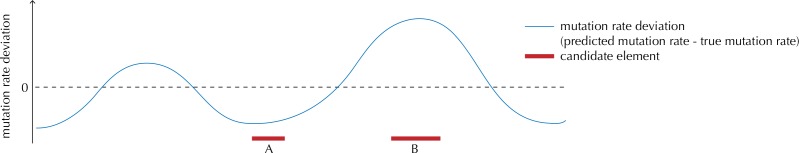
Illustration of the motivation behind the overdispersion-based rate adjustment.For candidate element A, we overestimate the mutation rate, and thus end up with a conservative p-value for this element when analysing it with ncdDetect. For candidate element B, on the other hand, we underestimate the mutation rate. In this case, ncdDetect will produce a p-value that is too small, creating a potential false-positive call. The effect of underestimating the mutation rate will be greater for longer candidate elements.